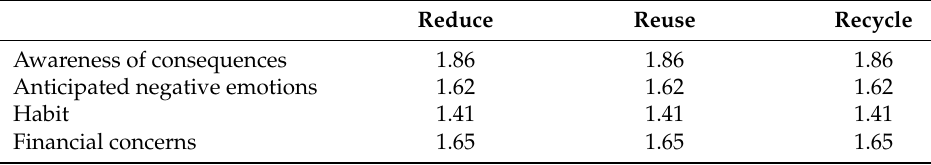
Table 4. Collinearity Test.